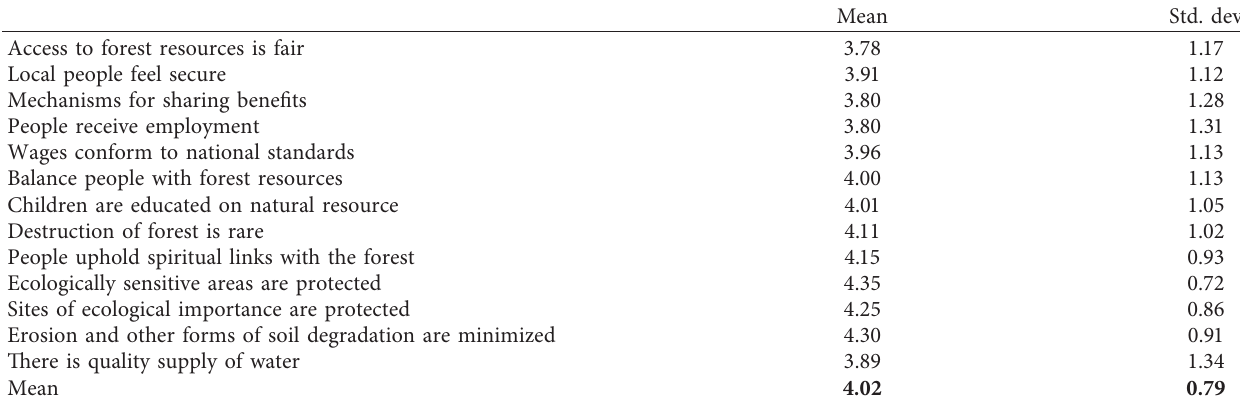
Table 2: Sustainable forest management.